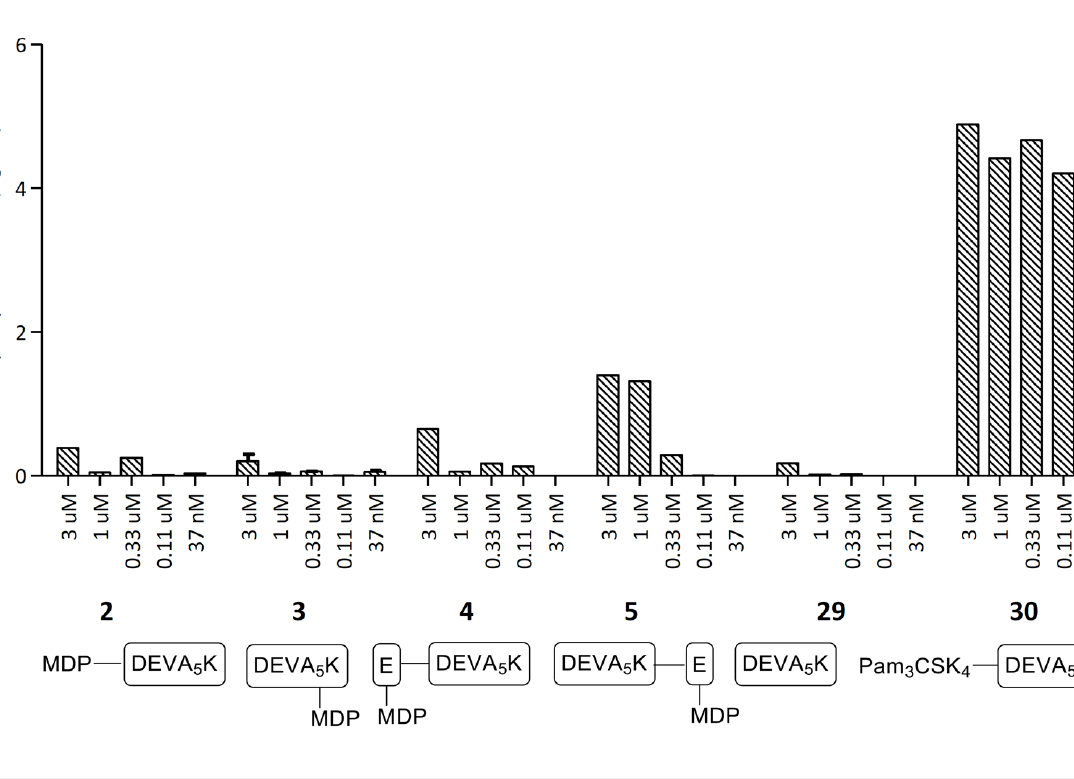
Figure 3: DC activation of the conjugates 2 – 5 and reference compounds 29 and 30 .